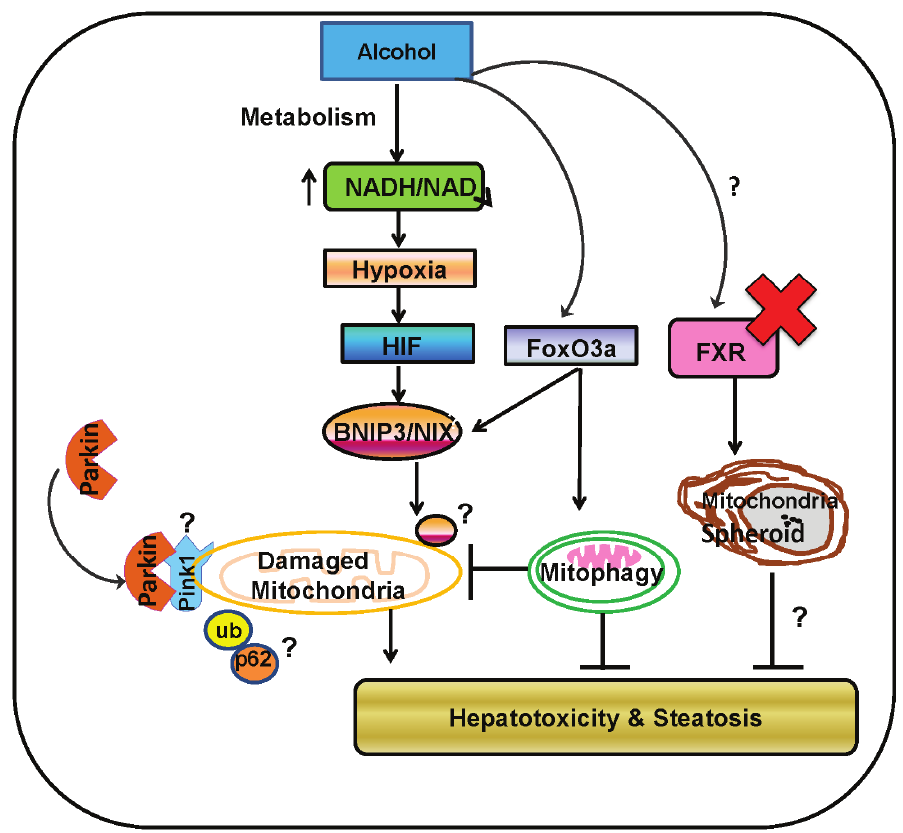
Figure 2. A proposed model for Parkin-dependent and-independent mitophagy and mitochondrial spheroid formation in alcohol-induced mitochondrial damage and liver injury. In ethanol- exposed hepatocytes, ethanol is metabolized by hepatic enzymes that lead to an increased NADH/NAD + ratio and subsequent mitochondrial damage. Ethanol induces Parkin translocation from cytosol to a depolarized mitochondrion, which is likely mediated by stabilization of the mitochondrial protein kinase PINK1 on the depolarized mitochondrion. Parkin then ubiquitinates outer mitochondrial membrane proteins, which further recruits autophagy receptor proteins such as p62 to the damaged mitochondrion and triggers selective mitophagy. Meanwhile, ethanol also activates HIF and FoxO3a transcription factors resulting in increased expression of the two atypical BH-3 domain containing proteins BNIP3 and NIX, which might also serve as selective mitophagy receptors by directly interacting with the autophagy protein LC3 to recruit autophagosomes to damaged mitochondria independent of Parkin. In the absence of the nuclear receptor FXR, ethanol also induces formation of mitochondrial spheroids, which may also serve as an alternative mitochondrial quality control pathway to protect against alcohol-induced liver injury. In general, mitophagy protects against alcohol-induced liver injury and steatosis by removing damaged mitochondria and improving adaptive capacity of mitochondria to stress. Modulating Parkin-dependent and-independent mitophagy may be a promising avenue for preventing and treating